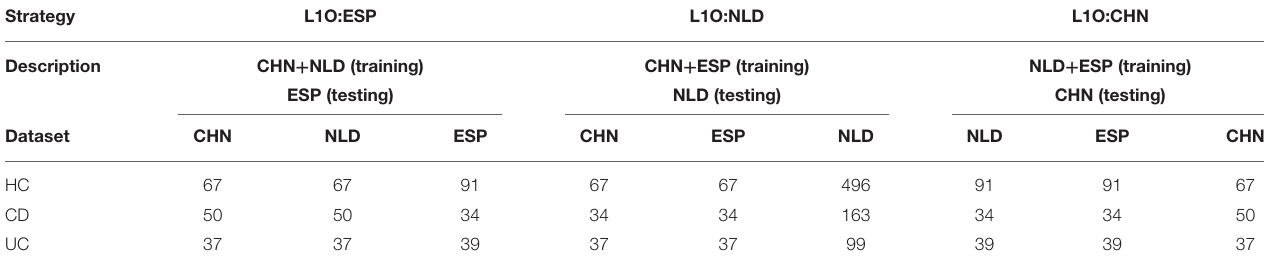
TABLE 2 | Number of samples per dataset and per classification group used for the L1O classification